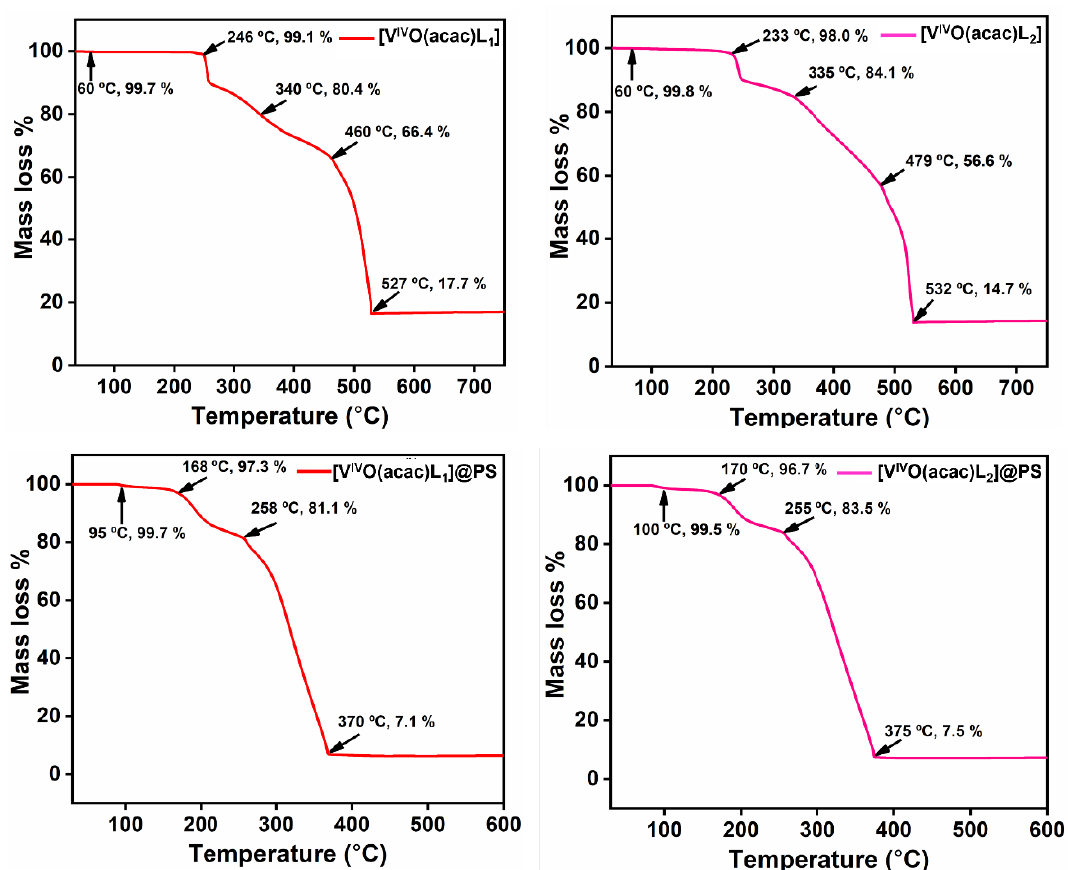
Figure 2. TGA profiles of complexes 1 , 2 , 3 and 4 .